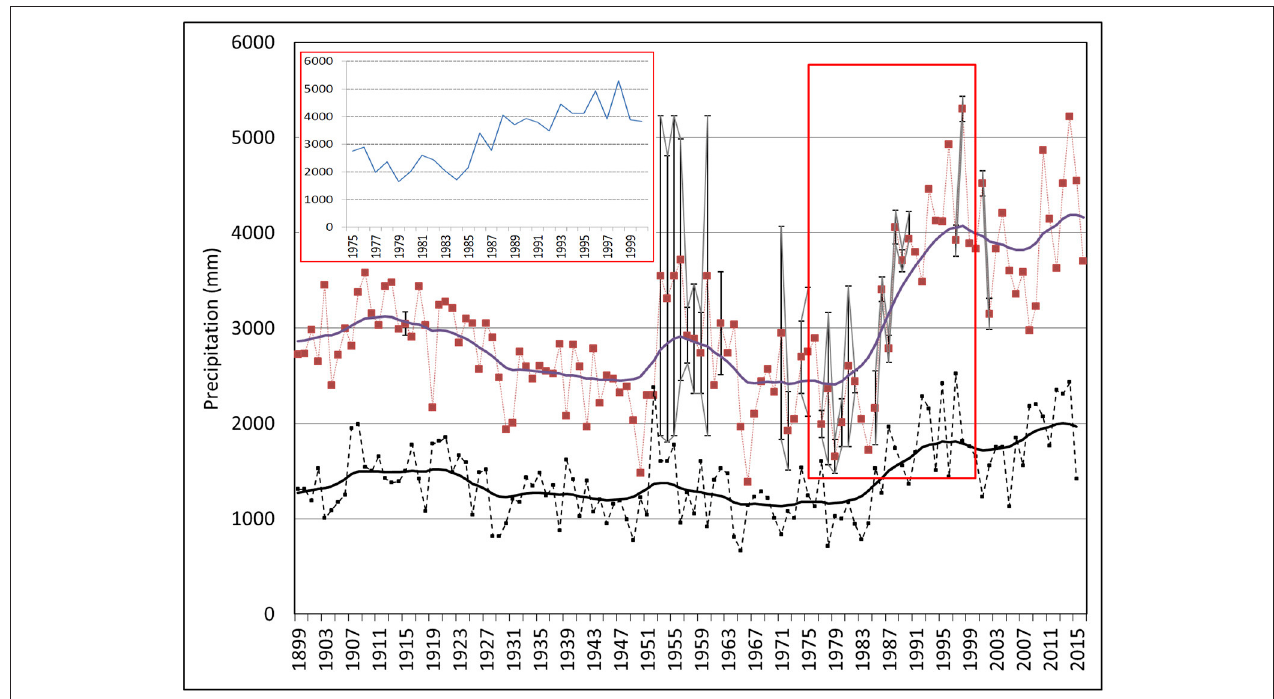
FIGURE 5 | Annual precipitation (red squares) at Evangelistas station over the period 1989–2016. The purple curve is the result of an exponential filter applied to smooth the original annual data (squares). Vertical lines in some years are the sum of the 1st standard deviation of the missing months, which were replaced by their respective monthly averages. The upper left inset shows a zoom of the 1975–2000 period. Lower curves (black) are the extended-winter (April-September) precipitation at Evangelistas station.